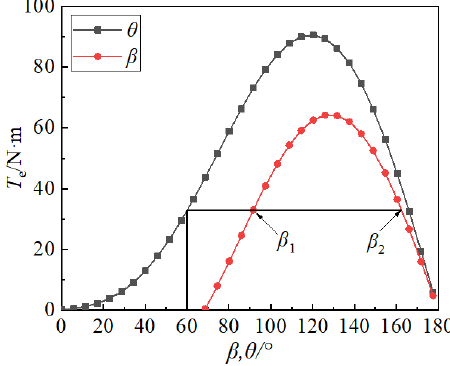
Figure 2. β corresponding solution at θ = 60.